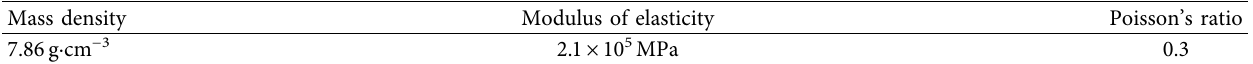
Table 4: Main parameters of nozzle and loading